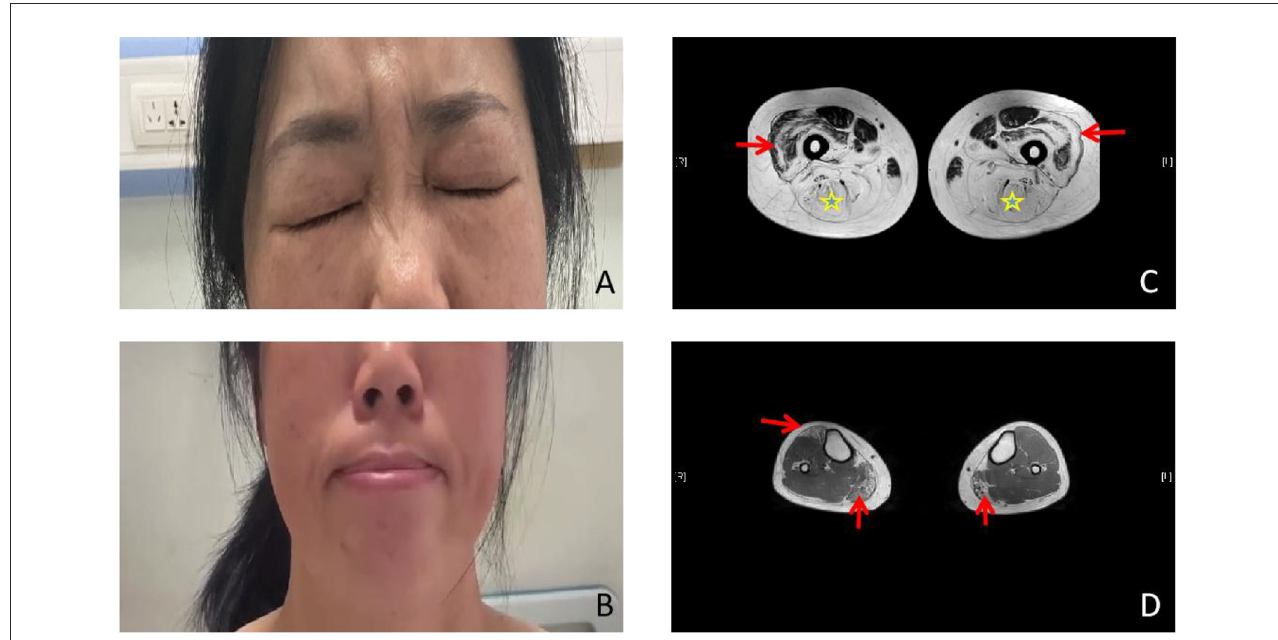
FIGURE1 Photographs and lower limb muscle magnetic resonance imaging (MRI). (A, B) Photographs of the proband. Weakness of the eye and lip muscles. (C) The bilateral posterior thigh groups were markedly enlarged (star), especially of the lateral femoral muscle edges and central preservation (arrow). (D) Significant enlargement of the medial head of the gastrocnemius (arrow ↑ ) and the anterior tibial muscles in both lower